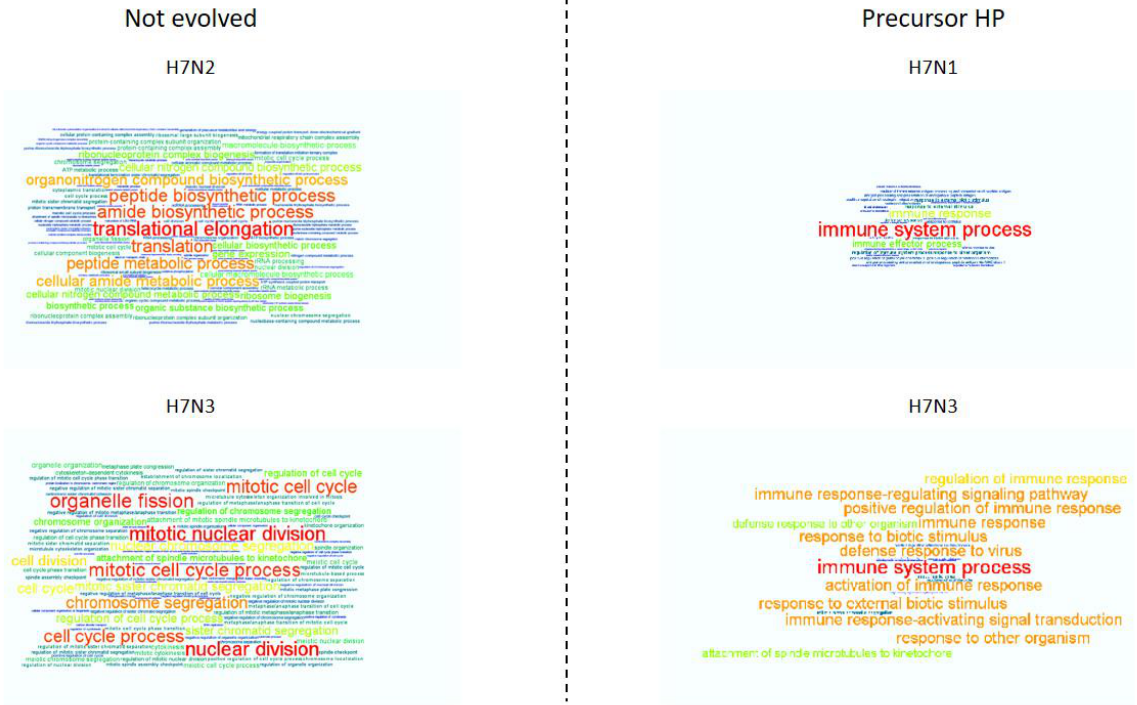
Figure 4. GO enrichment for the four time-course H7 infections, each with a separate word cloud. For each virus, we computed the enriched GO biological process terms at all timepoints. In case a GO term was enriched in multiple timepoints, we chose the one with the highest score, defined as − log10FDR. Font size and color (from the lowest to the highest value: blue, green, yellow, orange, red) are proportional to score. Word clouds have different values for highest score: from left to right then from top to bottom: 21.53, 7.10, 13.61 and 2.18.